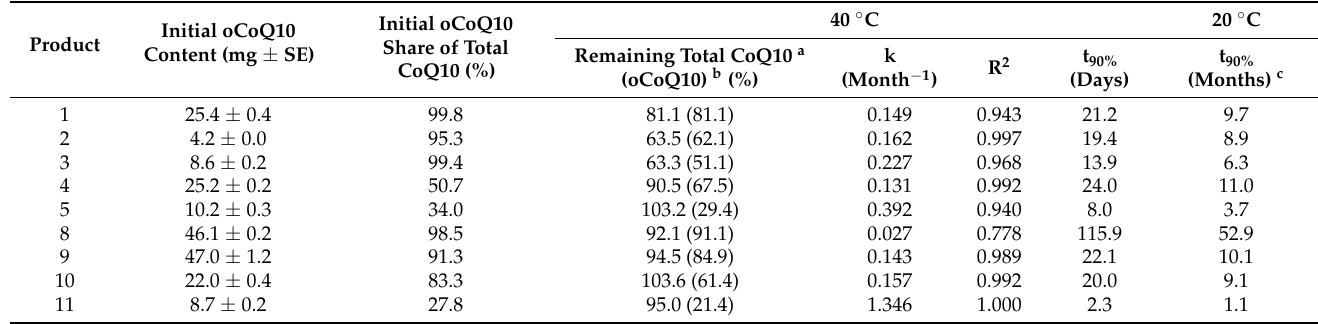
Table 2. Degradation of oCoQ10 in the tested products and extrapolation to ambient temperature.